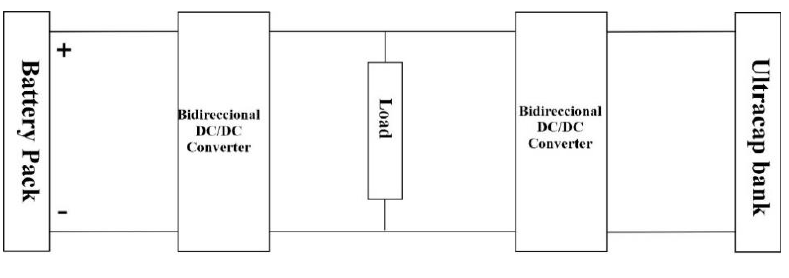
Figure 4. Multiple converter configuration (C-MC) [7].